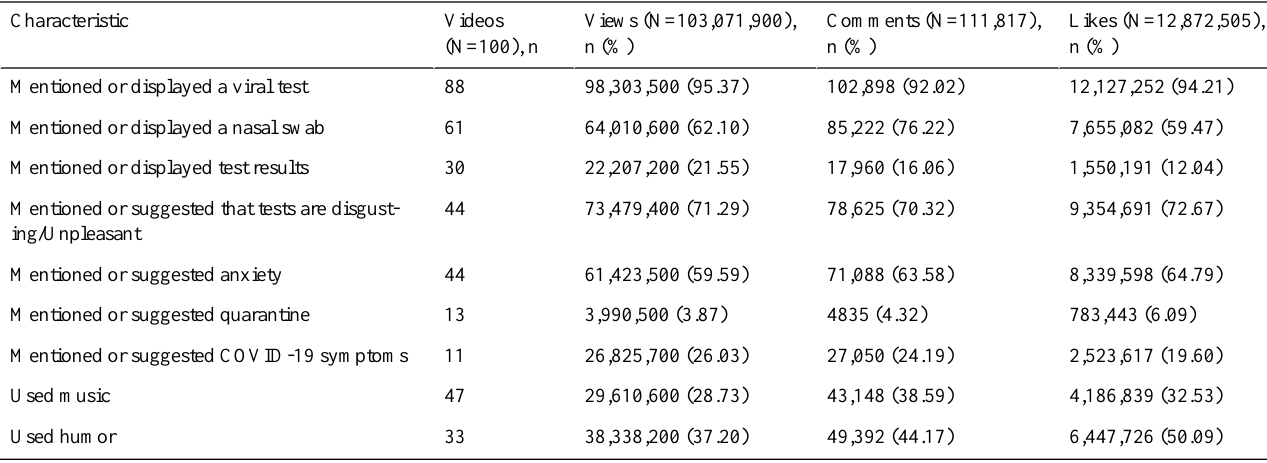
Table 1. Views, comments, and likes for COVID-19 testing–related videos on TikTok based on observed content characteristics.